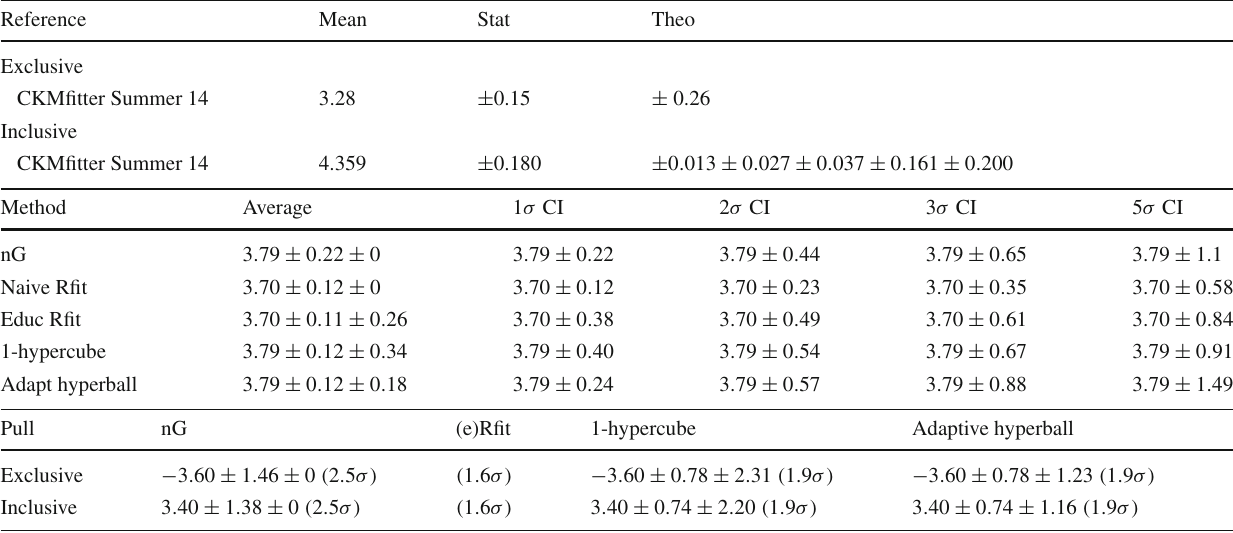
determining the minimum of the full (non-linear) χ 2 , and Table 9 Top: determinations of | V ub | · 10 3 from semileptonic decays. Middle: averages according to the various methods, and corresponding confidence intervals for various significances. Bottom: pulls associated to each determination for each method. For Rfit methods, we quote only